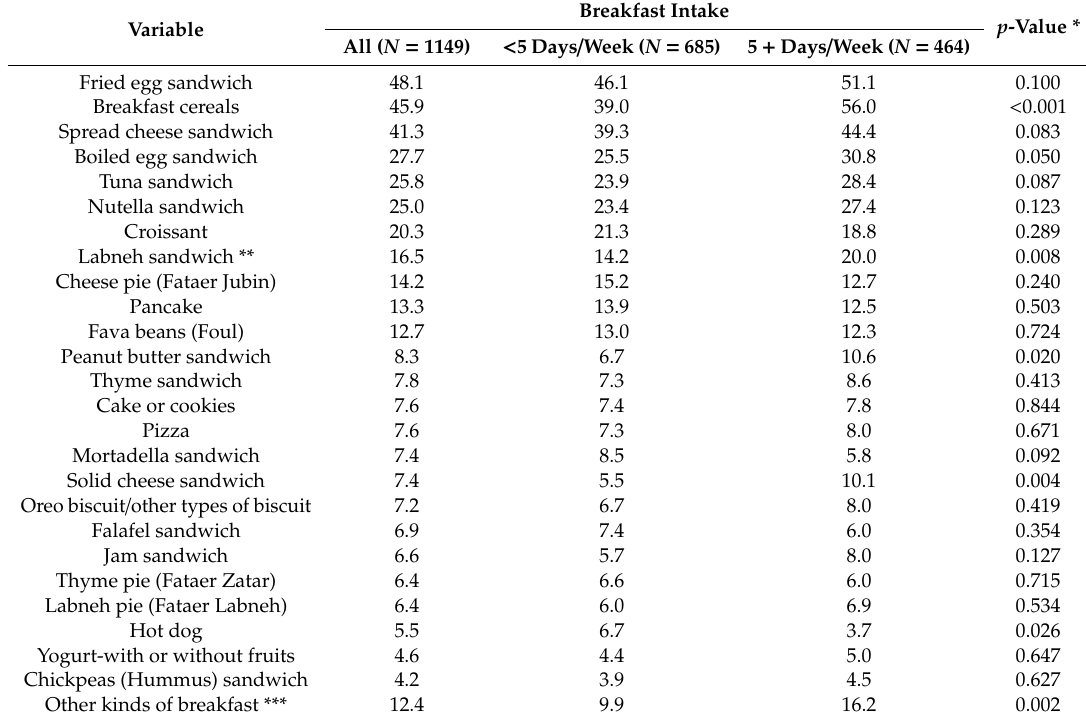
Table 4. Types of breakfast (%) eaten at home by Saudi children in relation to relative to high versus low breakfast intake frequency (more than one choice was possible).